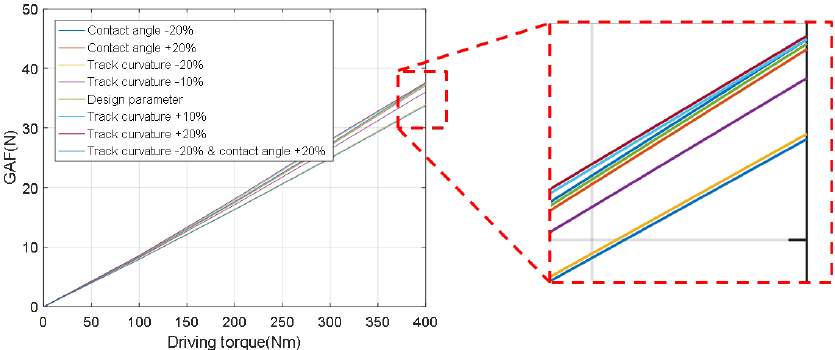
Figure 11. Estimated GAF with respect to design parameters.